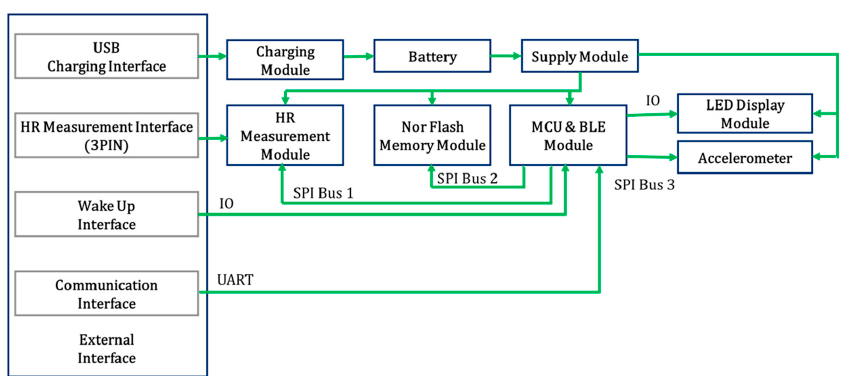
Figure 2. Circuit module diagram of the wearable smart T-shirt.